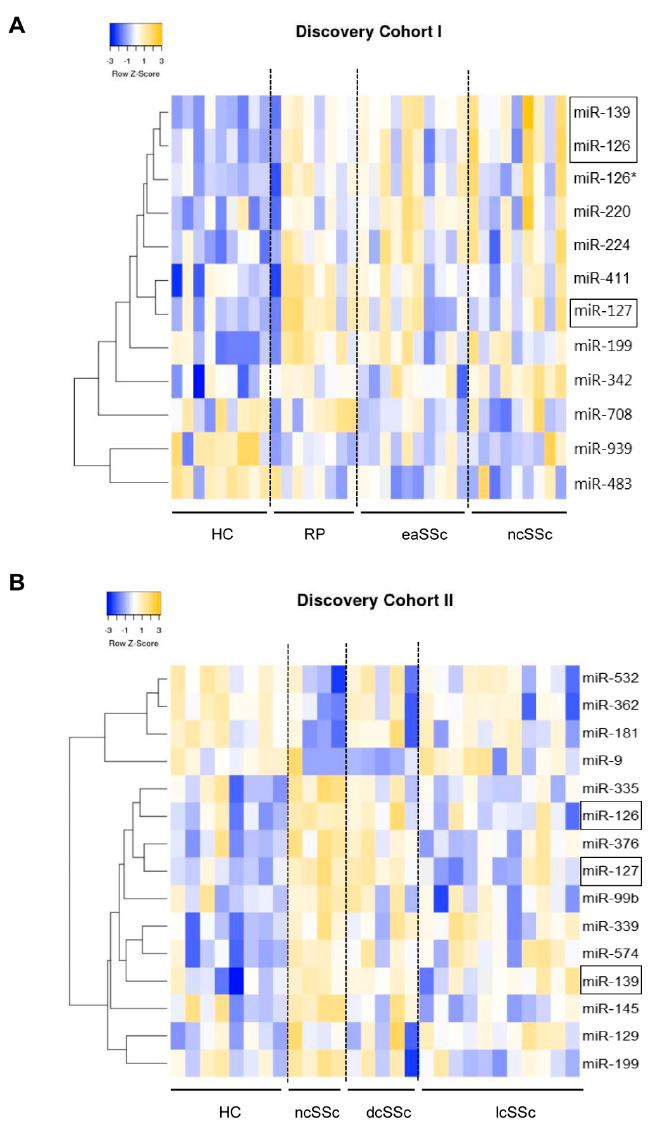
Figure 2. Differentially expressed miRNAs in circulating plasmacytoid dendritic cells of preclinical and definite SSc patients. Two independent experiments were performed for microRNA profiling in RNA extracted from pDCs of two different SSc cohorts using the OpenArray platform in discovery cohort I (HC = 9, RP = 8, eaSSc = 10, ncSSc = 9). ( A ) and discovery cohort II (HC = 8, ncSSc = 4, dcSSc = 5, lcSSc = 11); ( B ). Every donor was screened for 758 miRNAs, and no technical replicates were used. Data were normalized using ExpressionSuite Software (independent t-test, uncorrected p -value < 0.05). The expression of each miRNA was calculated as Fold Change (FC) as compared to the healthy control group. MiRNAs presented in heatmaps were differentially expressed with FC of ≥ 2 or ≤ 0.5 and a p -value of <0.05 in at least one patient group compared to healthy control group. Data are presented on the heatmaps as row z-scores computed from log transformed FC using hierarchical clustering with average linkage. The differentially expressed miRNAs in both cohorts are marked within boxes. HC, healthy controls; RP, Raynaud’s phenomenon; eaSSc, early SSc; ncSSc, non-cutaneous SSc; dcSSc, diffuse cutaneous SSc; lcSSc, limited cutaneous SSc. * indicates p -value <